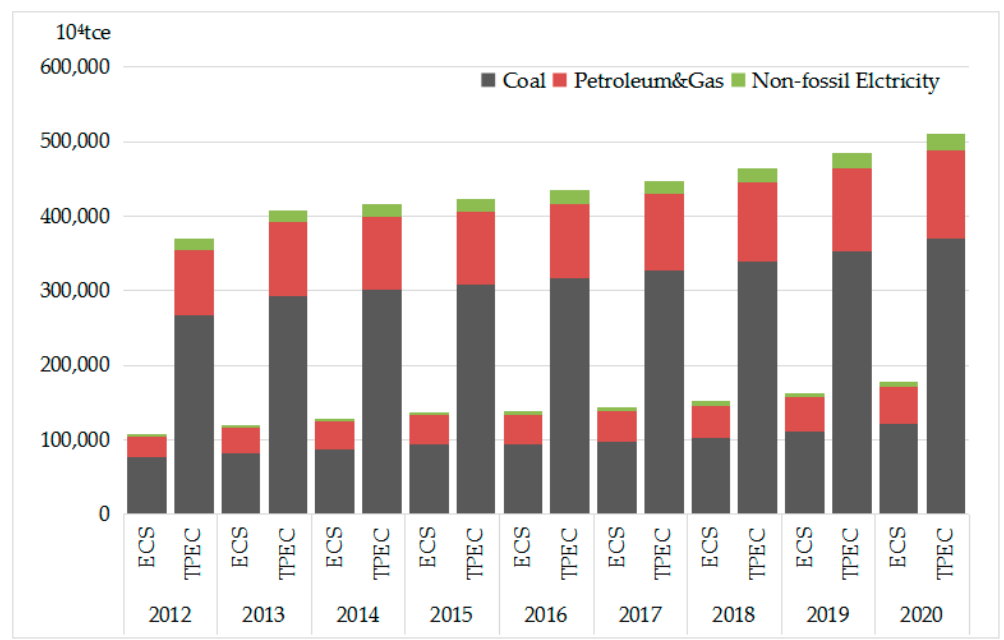
Table 8. The correction coefficient for the positive capital coefficient matrix.